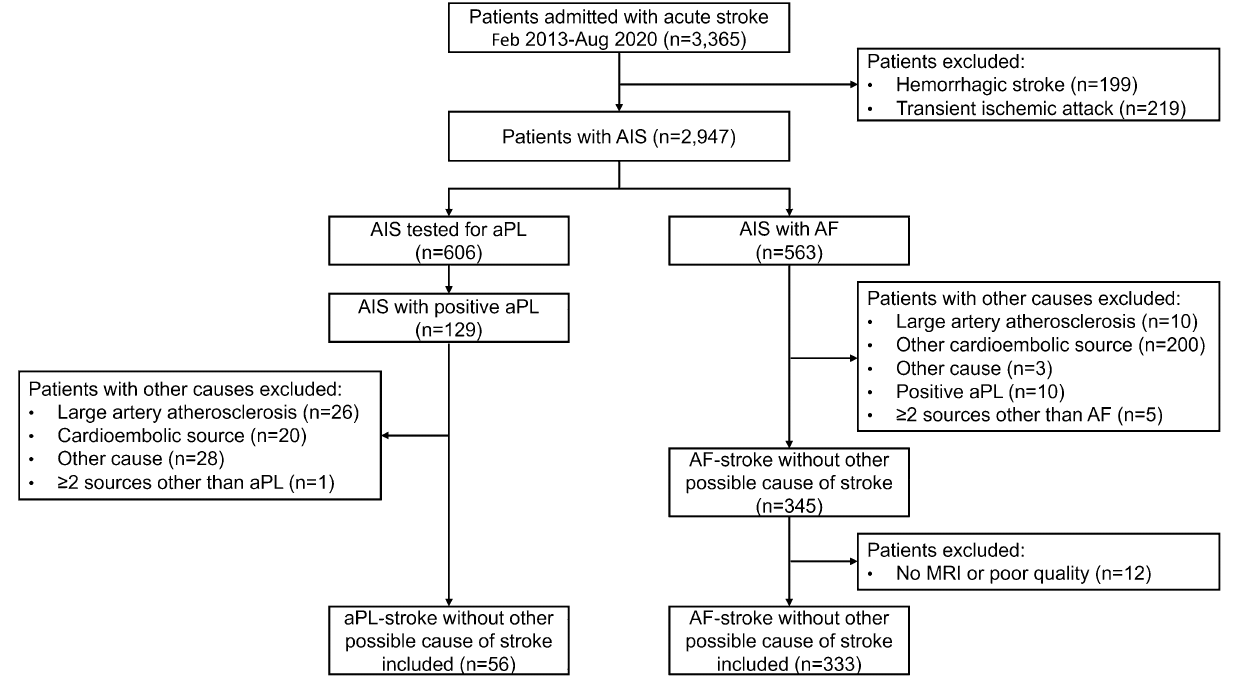
Figure 1. Flowchart of patient inclusion and exclusion. AF atrial fibrillation, AF-stroke atrial fibrillation-related stroke, AIS acute ischemic stroke, aPL antiphospholipid antibody, aPL-stroke antiphospholipid antibody-related stroke, MRI magnetic resonance